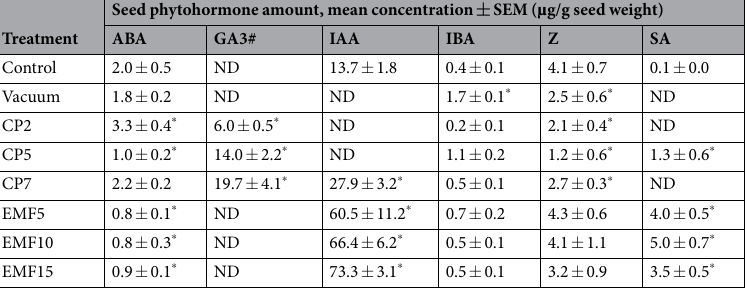
Table 3. The amount of phytohormones in sunflower seeds four days after treatment. # The amount GA7 was below detectable level in seed of all experimental groups. * Significantly different from the control group (p ≤